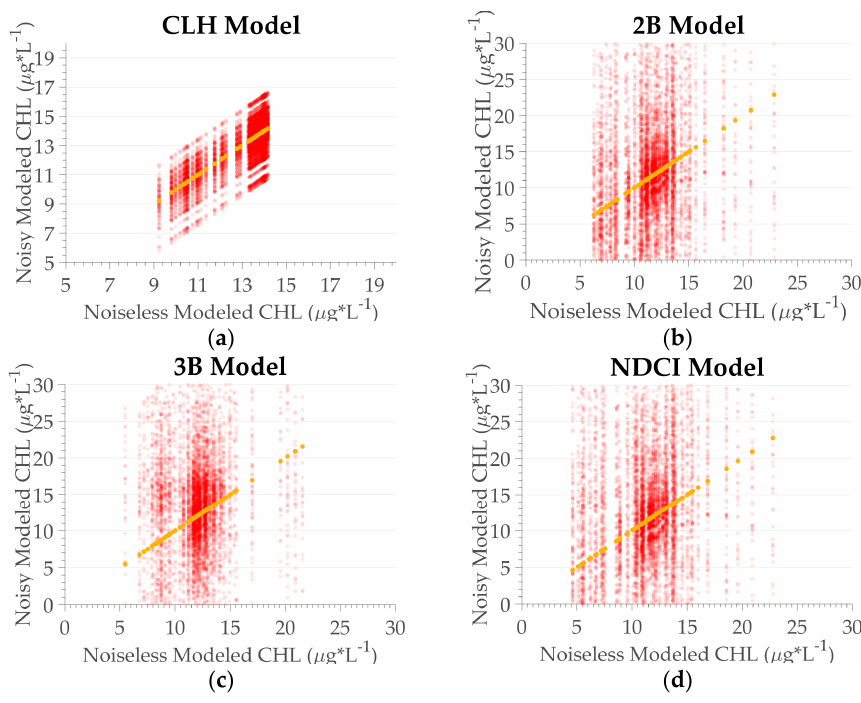
Figure 5. Algorithm performance for the chl-a concentration of the MSI sensor. ( a ) CLH ; ( b ) 2B ; ( c ) 3B ; ( d ) NDCI . Circles in red represent the data with noise, circles in yellow the noiseless data. The transparency is based on the frequency distribution, in which opaque indicates a higher frequency, and transparent indicates a lower frequency.